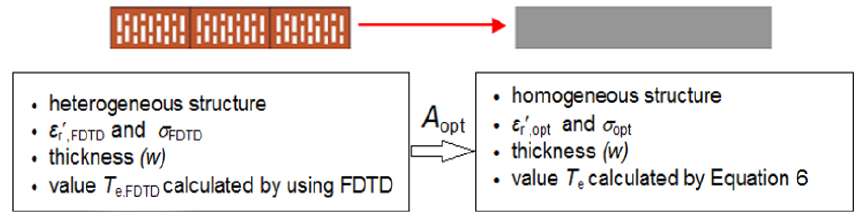
Figure 7. Homogenization scheme and connection of input and output data in the implementation of the developed algorithm ( A opt ).